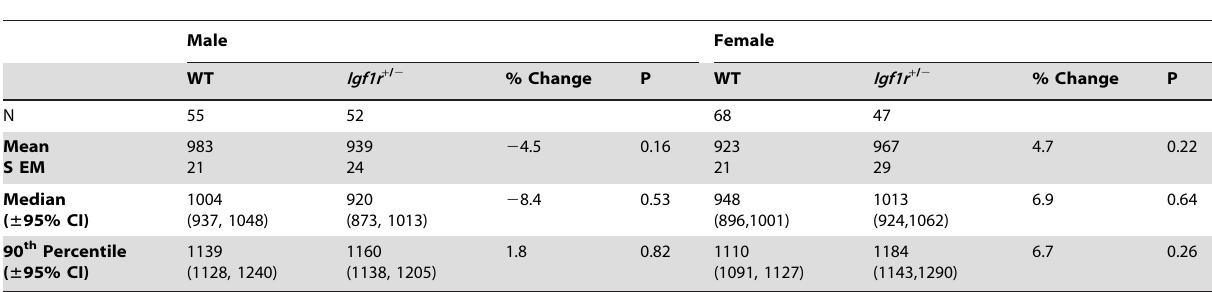
Table 1. A summary of lifespan data for WT and Igf1r + / 2